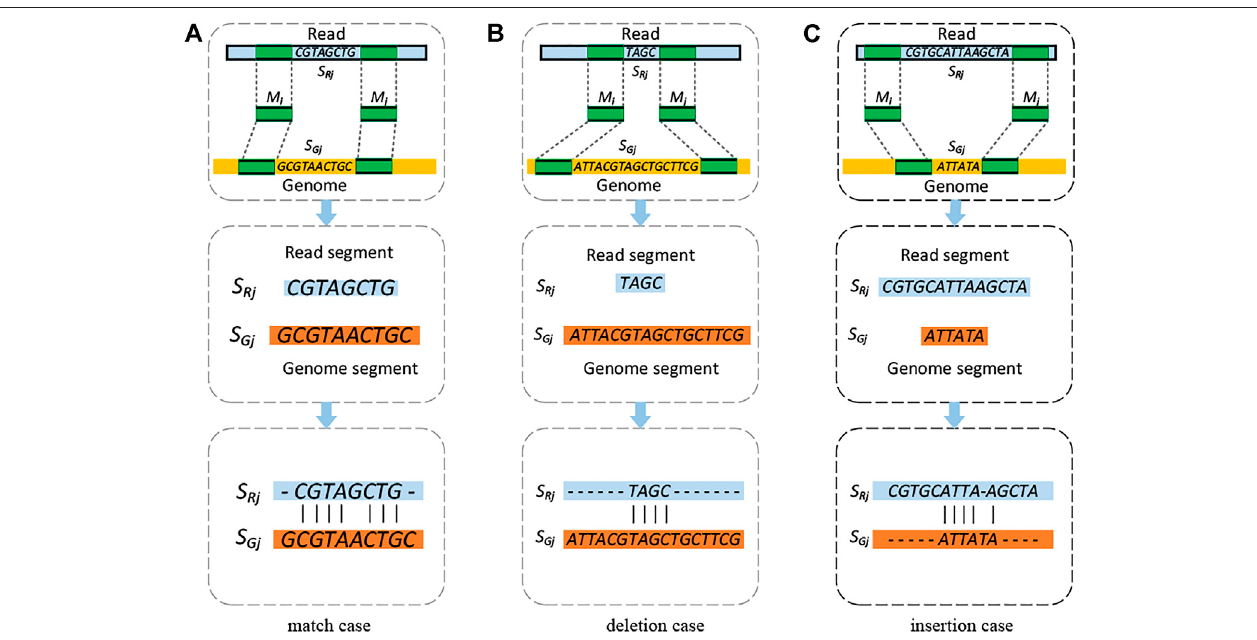
FIGURE2| Schematicillustrationofthethreecategoriesofunalignedsegmentsinthereadandgenome. (A) Match, (B) deletion,and (C) insertion.Inthe fi gure,the light blue, yellow, and green bars present the read, the reference genome, and the anchored k -mers, respectively. The dashed lines connecting the anchored k -mers indicatethematchedpositionsofthe k -mersonthereferencegenomeandtheread.Theclassi fi cationconditionsarebasedonthelengthsofpairofunalignedsegments. The second and third rows give an example on how to generate the alignment for each